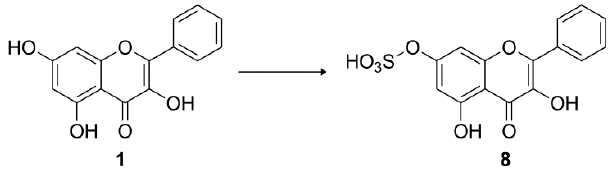
Figure 4. Microbial transformation of compound 1 by A. coerulea .